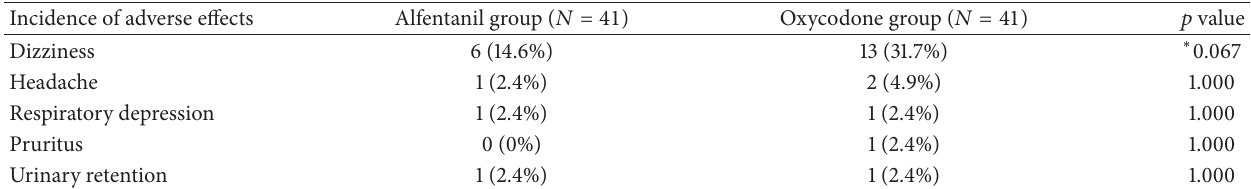
Table 3: Incidence rate of postoperative adverse effects.